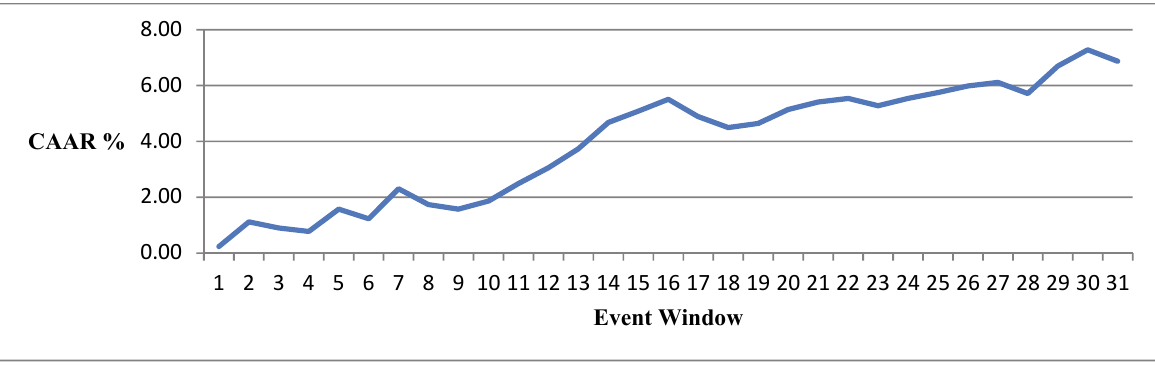
Fig. 4. AARs for Share Repurchase